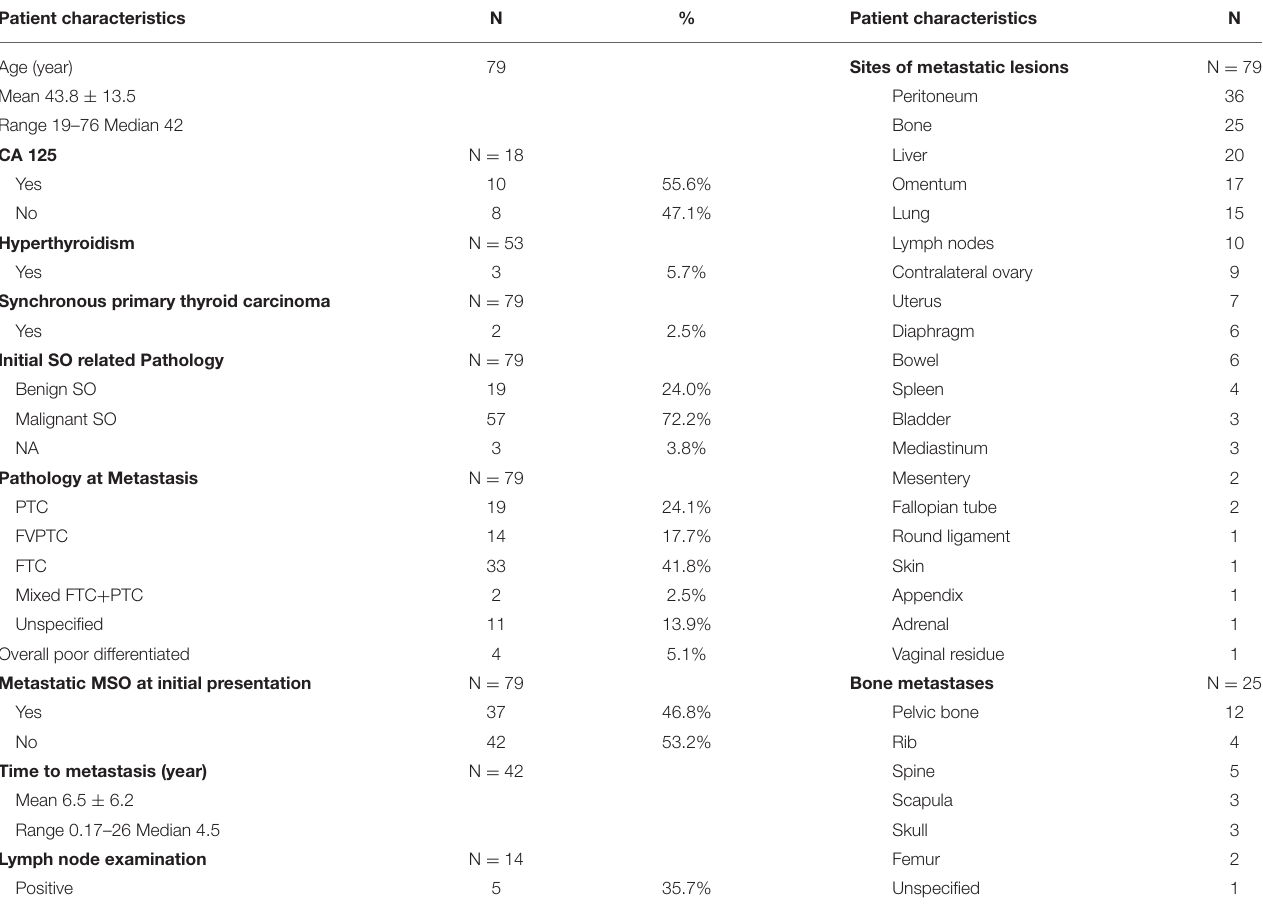
TABLE 2 | Clinical characteristics of patients with metastatic